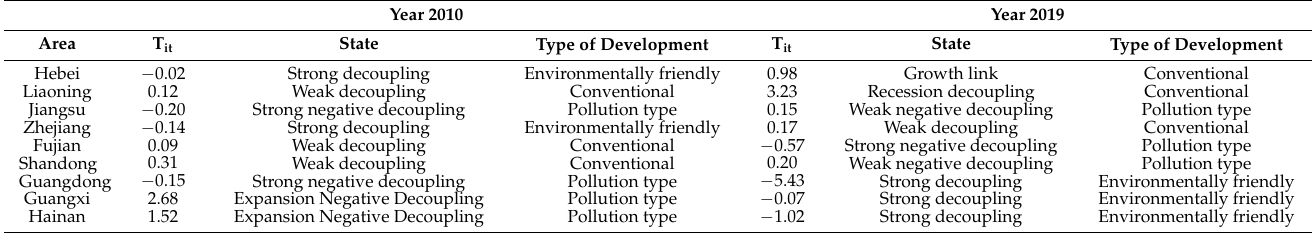
Table 15. Analysis of the decoupling relationship of the nine coastal provinces.